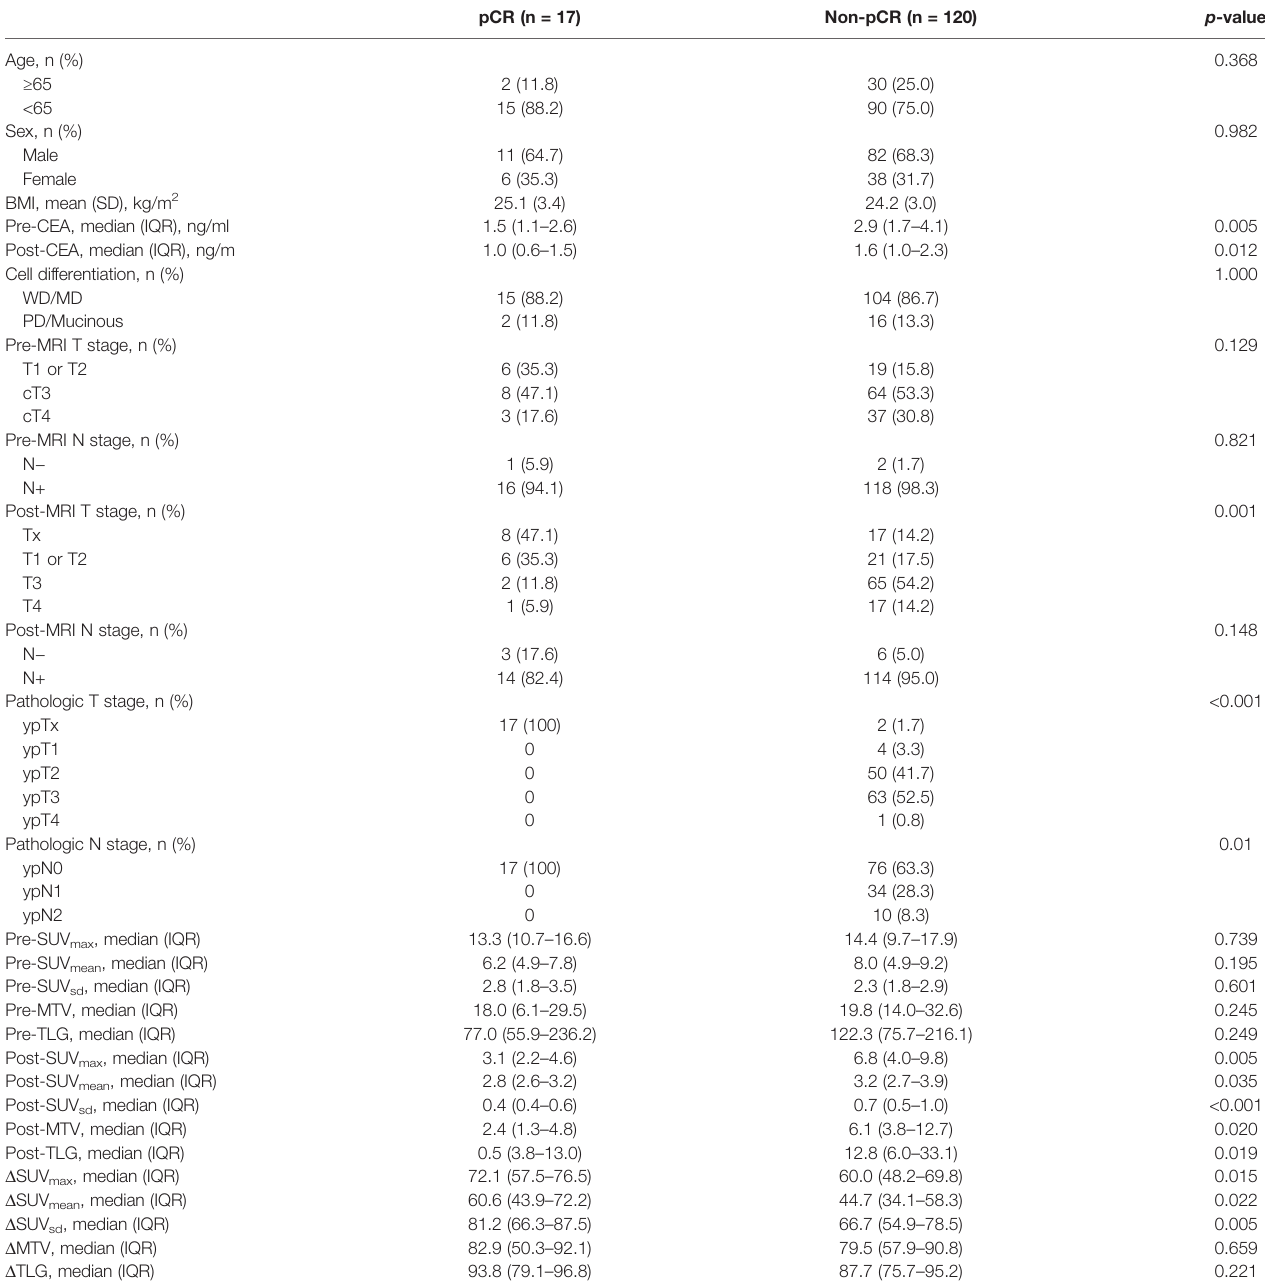
TABLE 1 | Comparisons of clinicopathological characteristics of patients who achieved pathological complete response and those who did